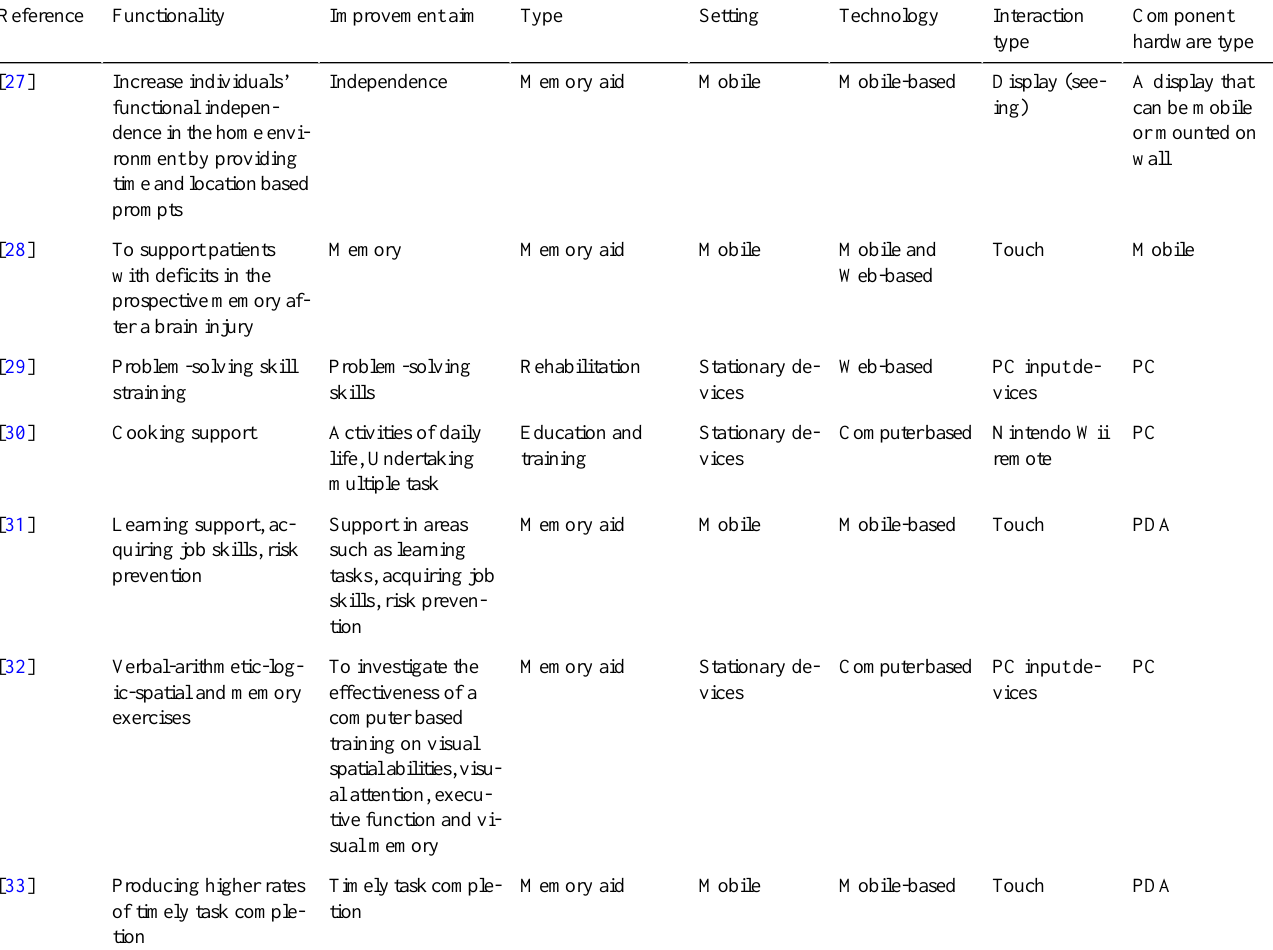
Table 5. Study features and functionality.